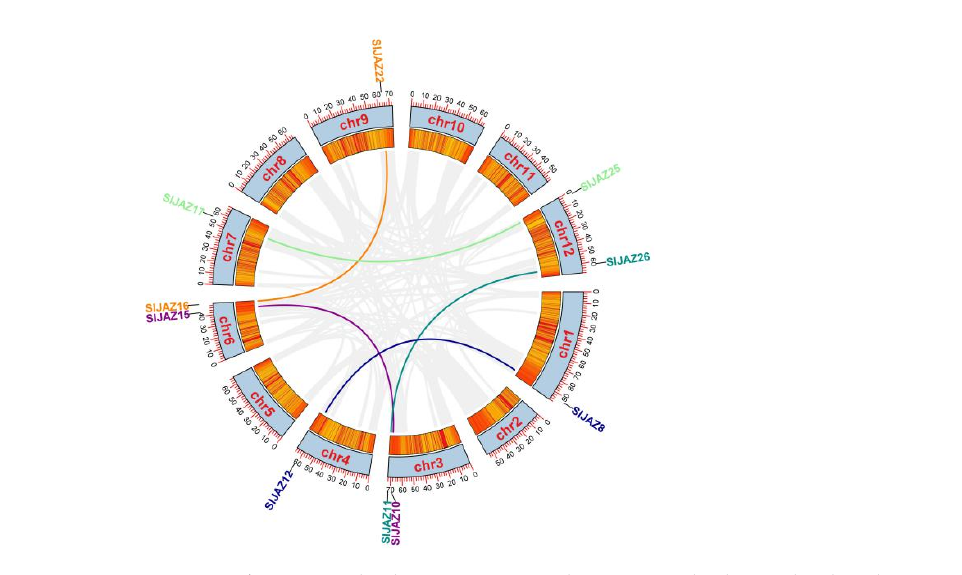
Figure 5. SlJAZ gene duplication events. The inner circle shows the distribution of genes on each chromosome. The gene names for each pair of duplication events are displayed in the same color.